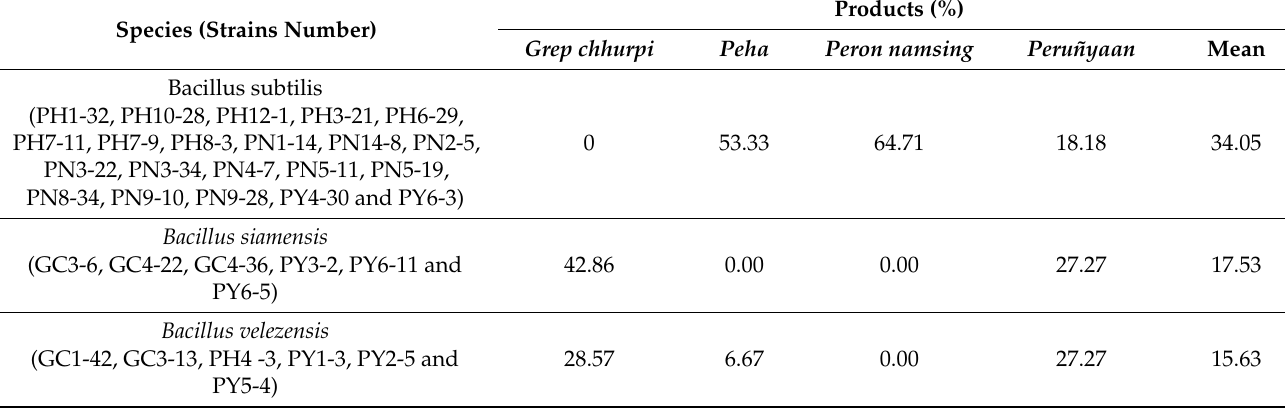
Figure 5. ( a ) Distribution (%) of the bacterial strains isolated from naturally fermented soybean products of Arunachal Pradesh based on stickiness and viscosity. ( b ) Graphical representation of the measurements of stickiness and dynamic viscosity of the identified Bacillus species isolated from fermented soybean products of Arunachal Pradesh, India. Table 1. Bacterial frequency and species diversity indices of Bacillus species isolated from fermented soybean products of Arunachal Pradesh, India.